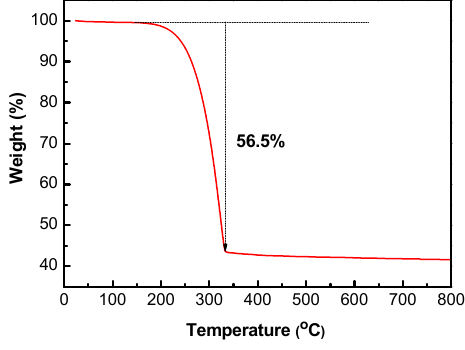
Figure 5. TGA plot of S/HPC composite.